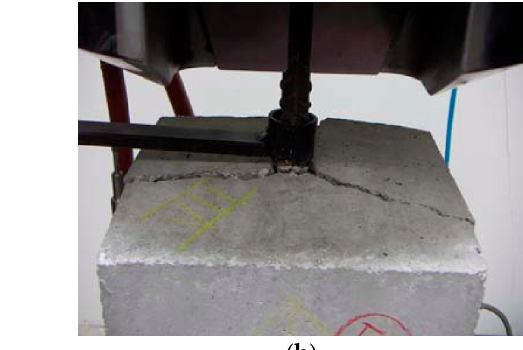
Figure 7. Concrete tensile failure: ( a ) specimen S25; ( b ) specimen S53.